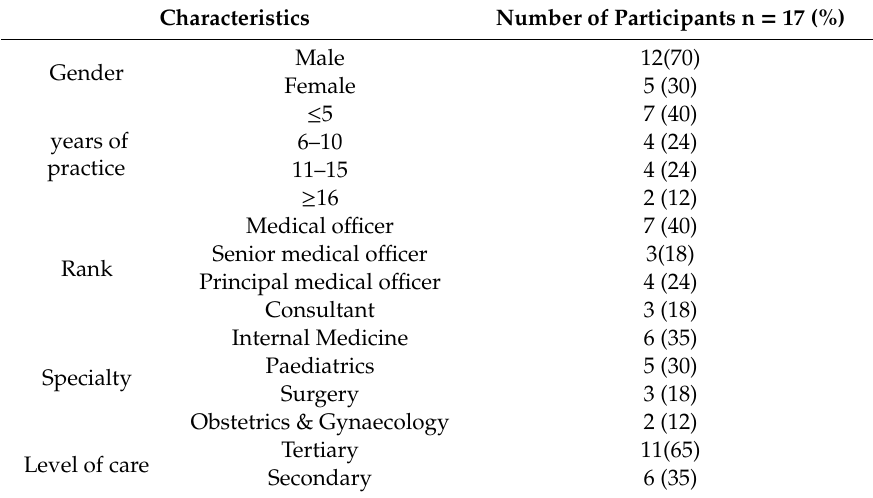
Table 1. Characteristics of